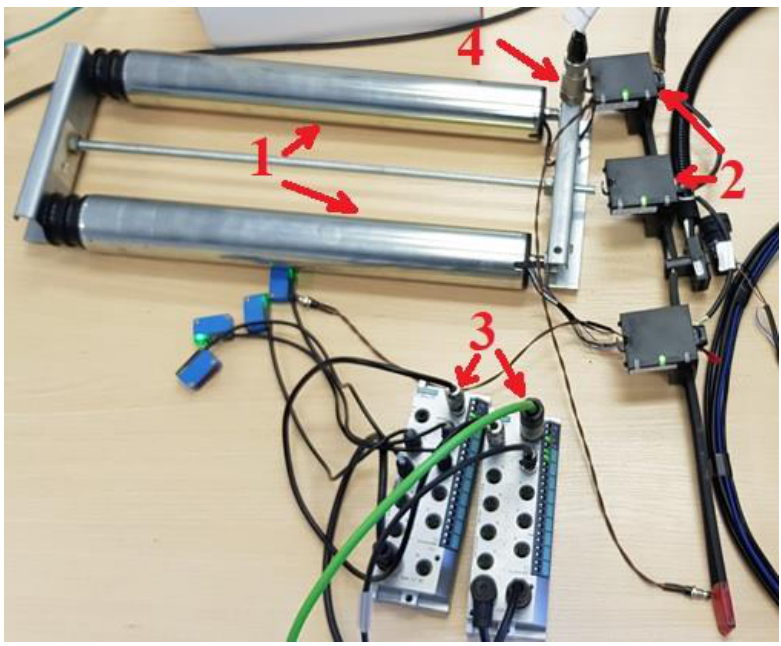
Figure 1. Test bench for the experiment.